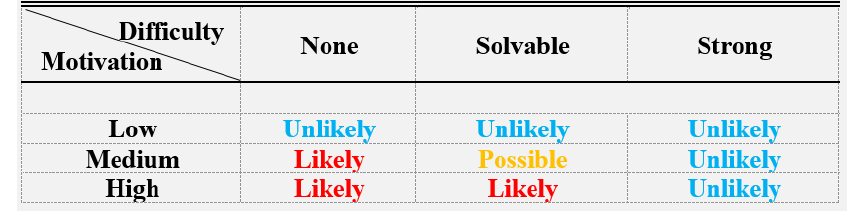
Figure 3. Likelihood of an